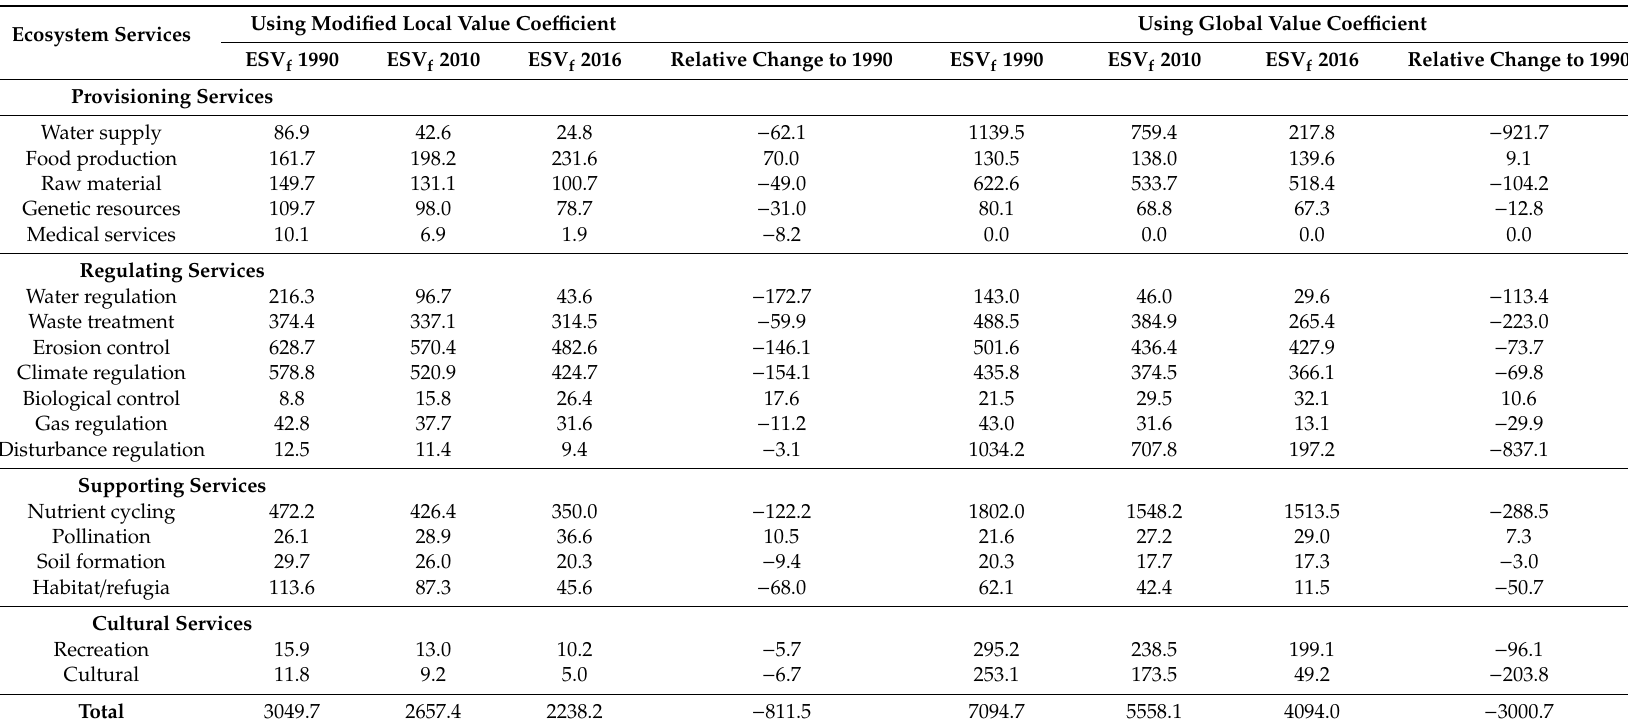
Table 7. Estimated annual value of the ecosystem functions (ESV f in US$ million per year) under each services category for the di ff erent years and the changes between years